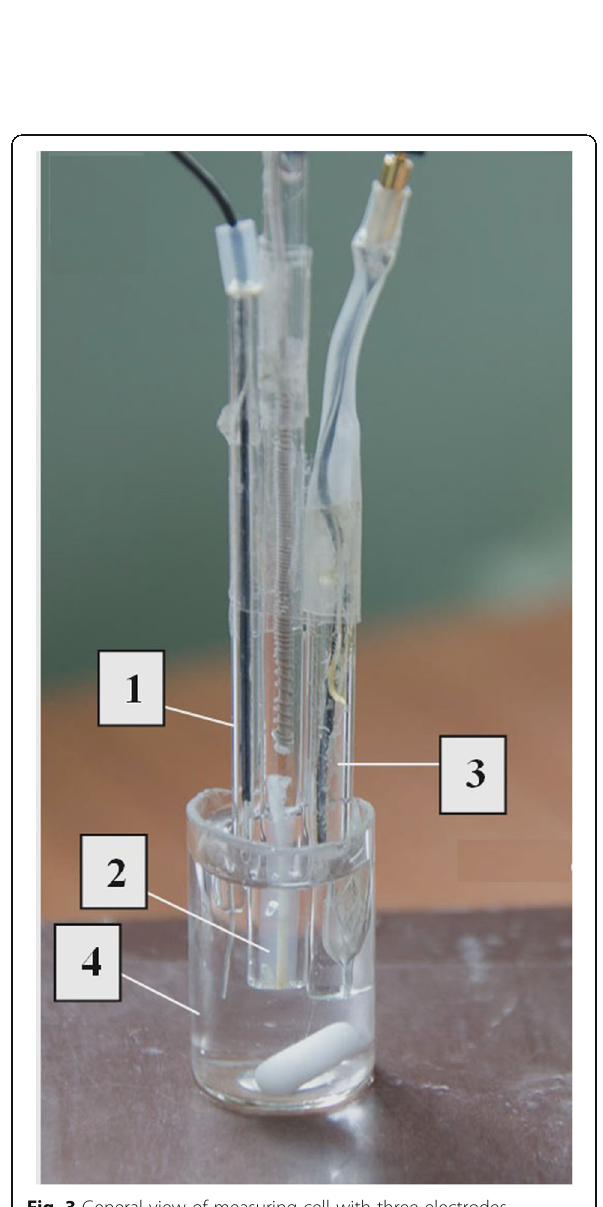
Fig. 3 General view of measuring cell with three electrodes ( 1 auxiliary electrode, 2 Ag/AgCl reference electrode, 3 working electrode, and 4 working cell with 2 ml of buffer solution and magnetic stirrer)